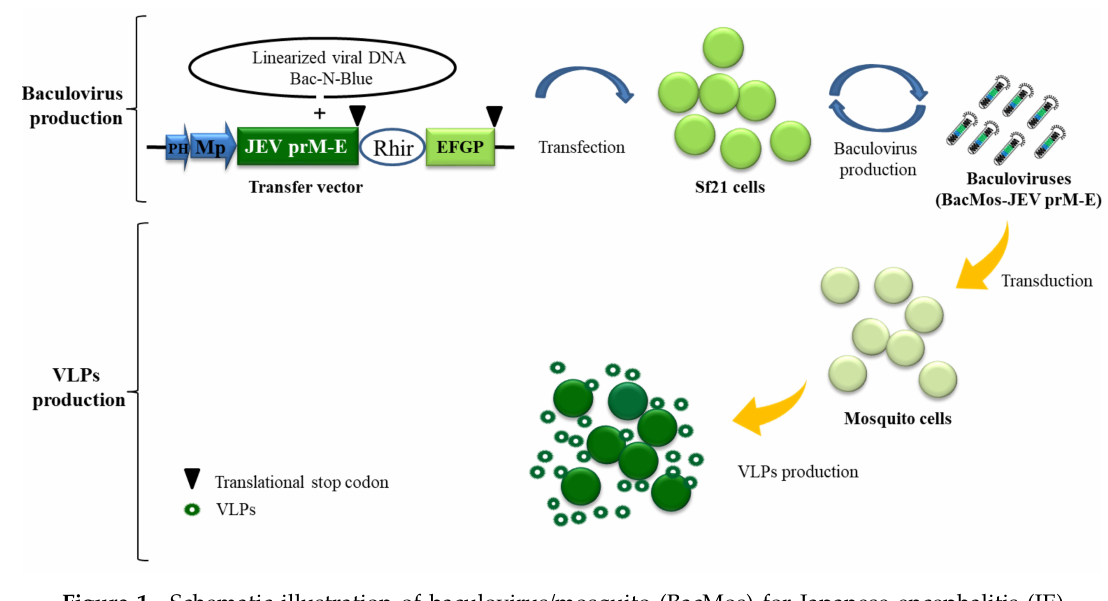
Figure 1. Schematic illustration of baculovirus / mosquito (BacMos) for Japanese encephalitis (JE) virus-likeparticles(VLPs)production. ArecombinantbaculovirusbearingaDNAcasttestofPH-Mp-JEV precursor membrane protein and envelope (prME)-Rhir-EGFP generated by a Bac-N-Blue system are produced from Sf21 cell. Mosquito cells are e ffi ciently transduced by baculoviruses (BacMos-JEV-prME), and JEV prME expression and VLP (hollow green circles) secretion were induced. Abbreviations: PH, polyhedrin promoter; Mp: Mosquito promoter (hr1pag1); JEV prME: an insect codon-optimized JEV prME gene (AAB66485, 105-794th amino acid); Rhir, RhPV 5 (cid:48) -UTR IRES; EGFP, enhanced green fluorescent protein